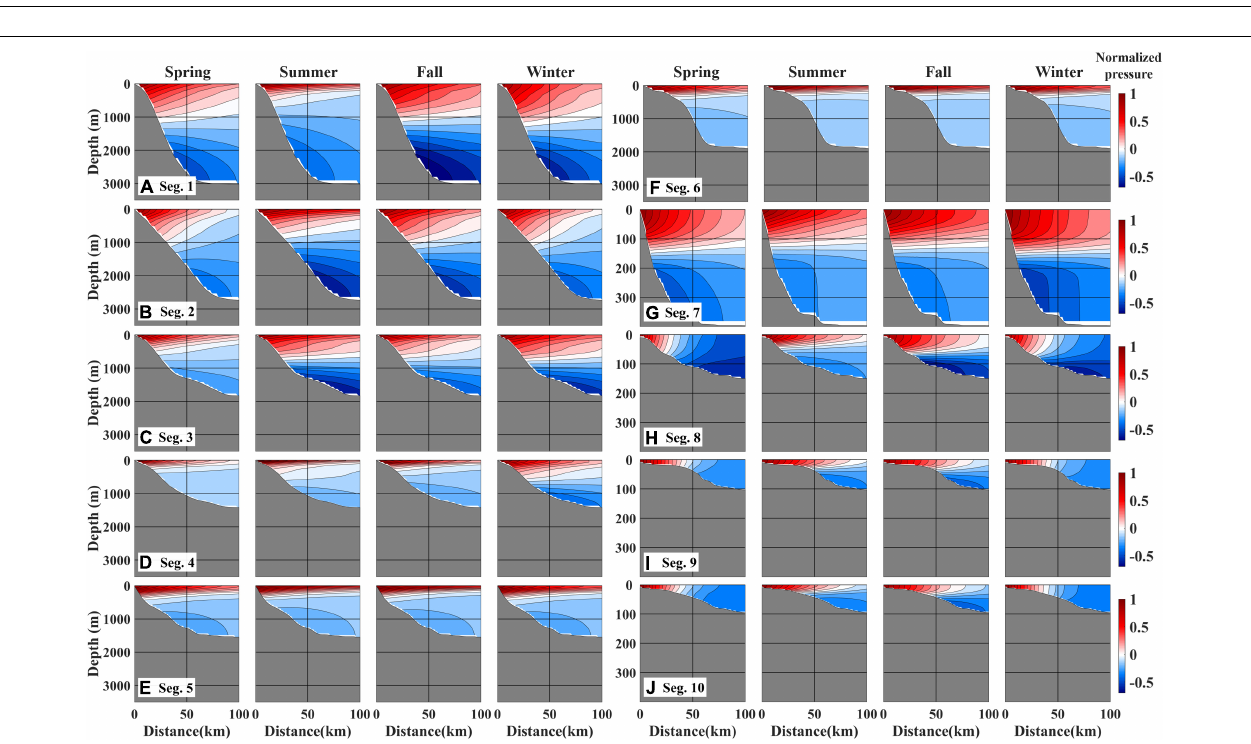
FIGURE 6 | Cross-sectional modal structures ( F 1 ) of the normalized pressure for the mode-1 CTWs in four seasons and ten segments (A–J) . Water depth ( y -axis) ranges from the surface to 3,500 m for Segs. 1–6 (A–F) and 400 m for Segs. 7–10 (G–J) .